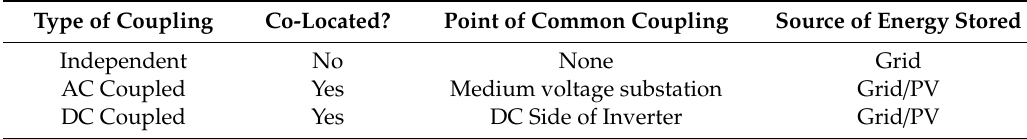
Table 1. Di ff erent types of system configurations for Photovoltaic (PV) plus battery storage systems. Type of Coupling Co-Located? Point of Common Coupling Source of Energy Stored